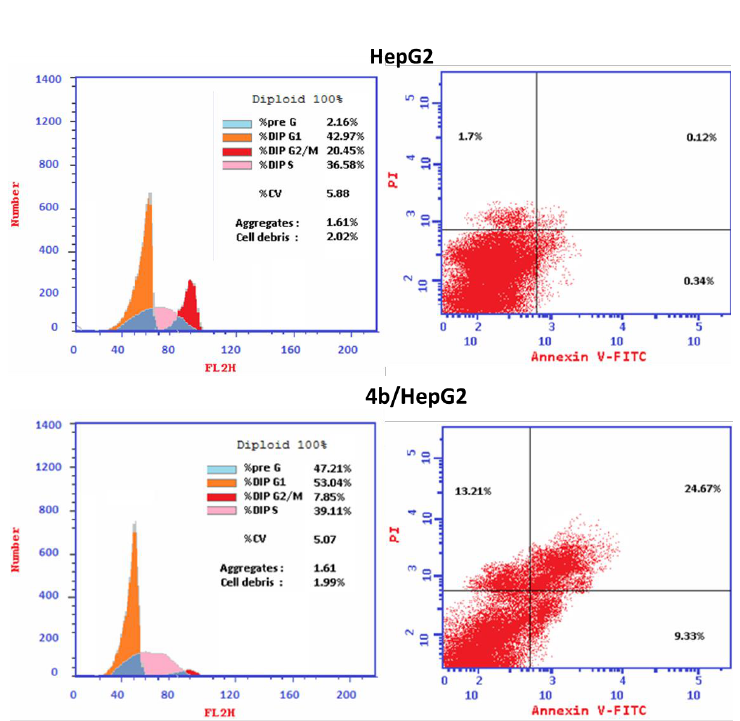
Figure 5 . Cell cycle analysis and Apoptosis induction analysis using Annexin V/PI of hybrid 4b in HepG2 cancer cell.